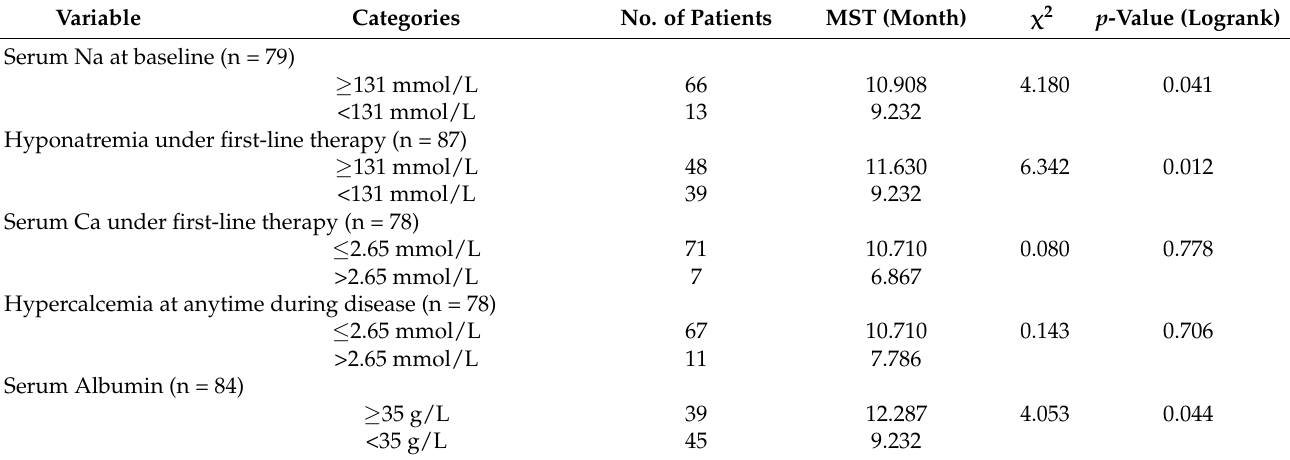
Figure 1. ( A ) Kaplan–Meier graph for overall survival according to staging. N = 87. LD = limited disease (n = 21); ED = extensive disease (n = 66). ( B ) Kaplan–Meier graph for overall survival according to number of metastatic sites. N = 87; 0 or 1 metastatic site: n = 34; 2 or more metastatic sites: n = 53. ( C ) Kaplan–Meier graph for overall survival according to liver metastases. N = 87. No liver metastases: n = 54; liver metastases: n = 33. ( D ) Kaplan–Meier graph for overall survival according to bone metastases. N = 87. No bone metastases: n = 57; bone metastases: n = 30. ( E ) Kaplan–Meier graph for overall survival according to adrenal gland metastases. N = 87. No adrenal gland metastases: n = 68; adrenal gland metastases: n = 19. Table 2. Univariate analysis of laboratory parameters at baseline.